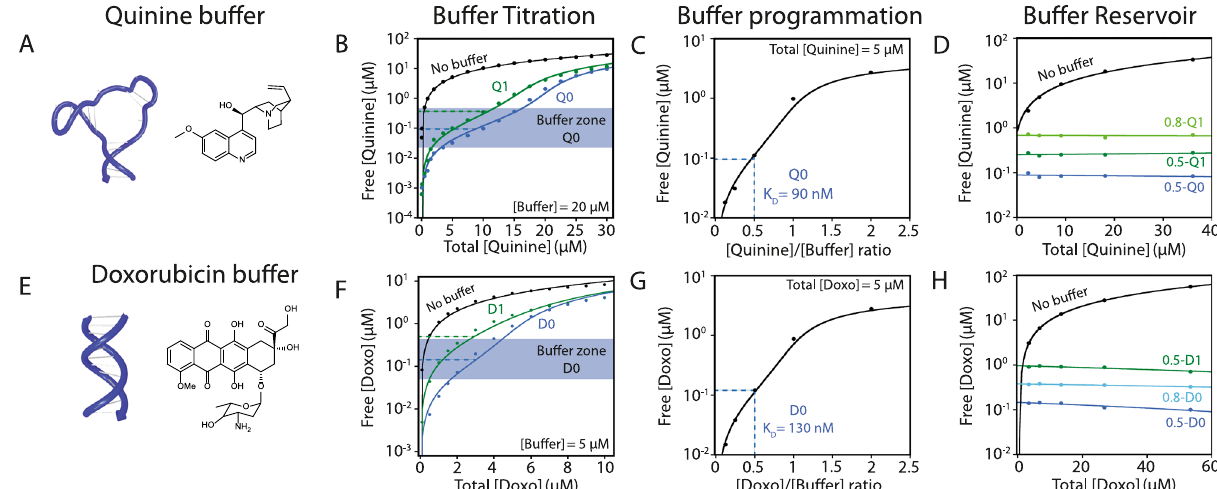
Fig. 2 | Programming the buffer capacity of molecular buffers. Quinine ( A – D ) and doxorubicin ( E – H ) buffers maintain the concentration offree quinine and free doxorubicin near their K D values even in a large drug concentration range. B , F Increasing the dissociation constant of the buffer, K D , increases the con- centration of free drug proportionally with buffer variants Q1 and D1 for example (black line: no buffer added; green line: D1 and Q1 buffer variant; blue line: D0 and Q0 buffer variant). Data fi tted with equation E5 — see Supplementary